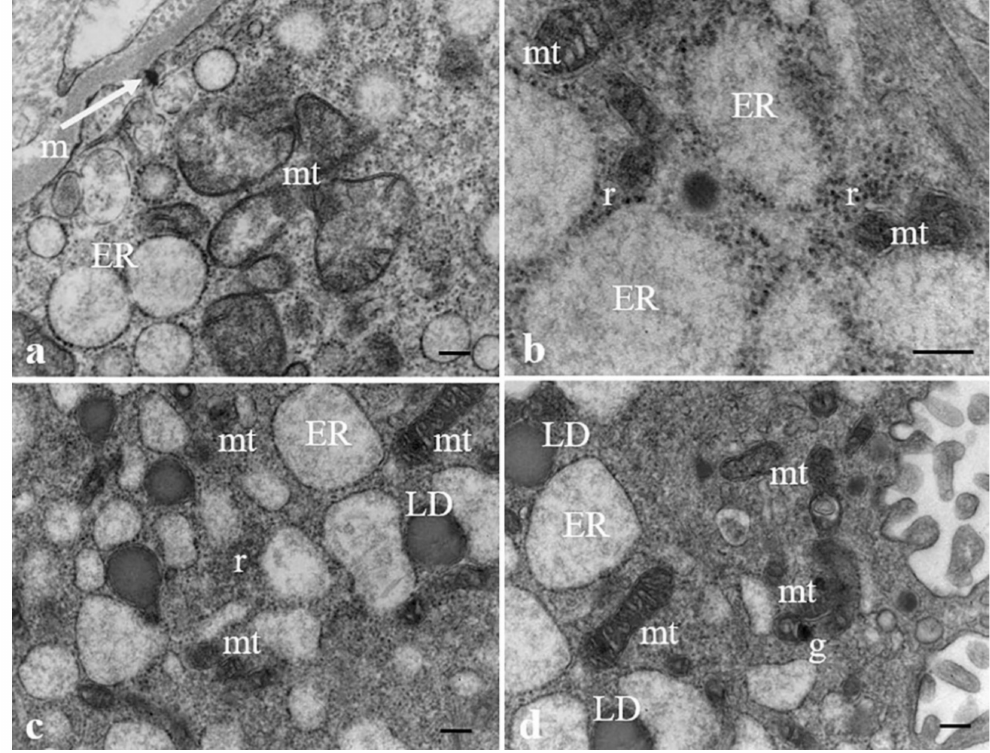
Figure 5. Ultrastructural changes of organelles in the syncytiotrophoblast layer. ( a ) A MP (arrow) is present close to basement membrane. The endoplasmic reticulum (ER) appears dilated, with sparse ribosomes on the outer surface. ( b ) Ribosomes (r) result free in the cytoplasm and ( a , b ) swollen mitochondria (mt) next to ( c , d ) smaller, pycnotic and electrodense mitochondria are evident in the cytoplasm. ( d ) Mitochondrial matrix contains prominent electron-dense granules (g). Lipid droplets (LD) close to ER dilatated vesicles are also present ( c , d ). Bar, 200 nm. Structural changes of the same organelles and the presence of whorled membranous bodies probably derived from involuting endoplasmic reticulum, mitochondria, autolyso- somes containing mitochondria, mitochondrial remnants, and other structures that also appear in the cytotrophoblast cells, as demonstrated in Figure 6a–c. Endoplasmic reticulum dilated vesicles and swollen electrodense mitochondria also occur in endothelial cells surrounding the sinusoids